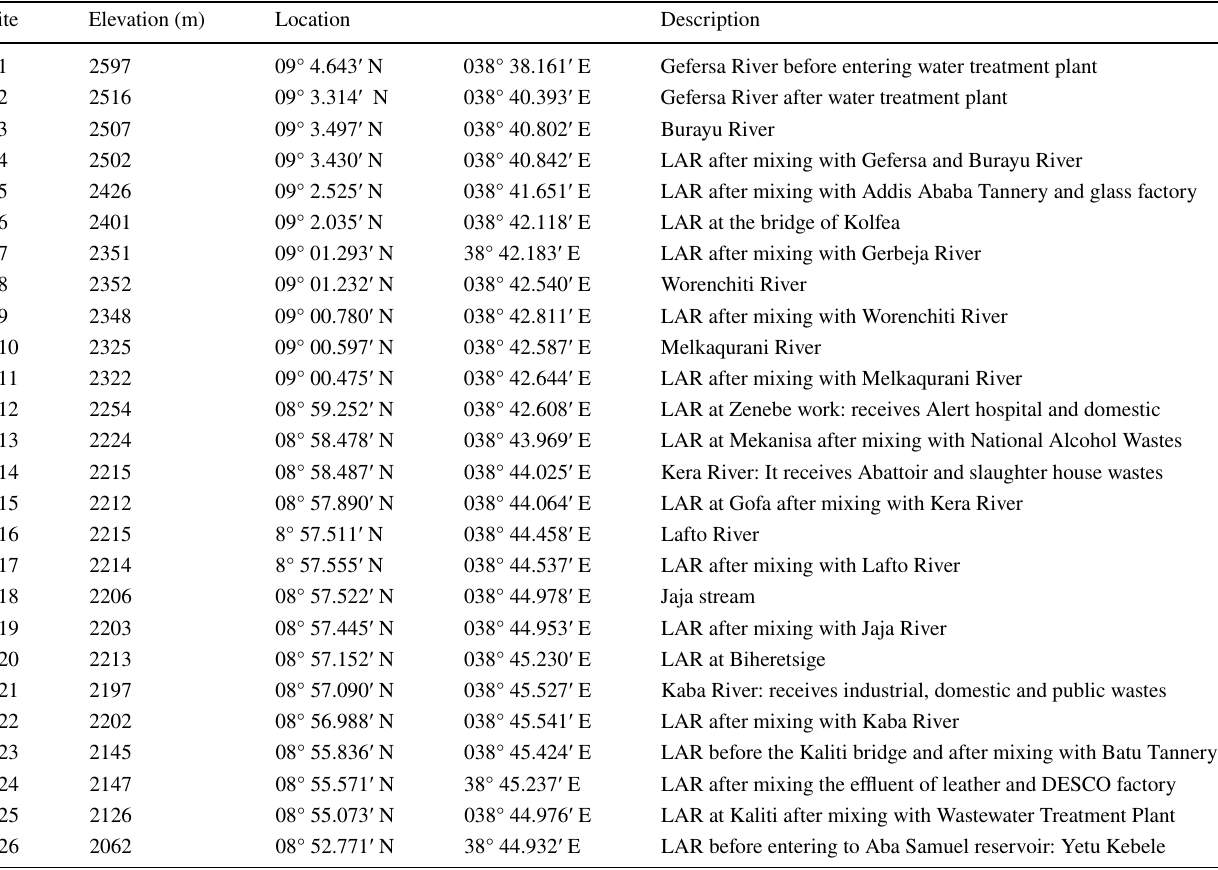
Table 1 Description of sampling sites in the study area in Addis Ababa